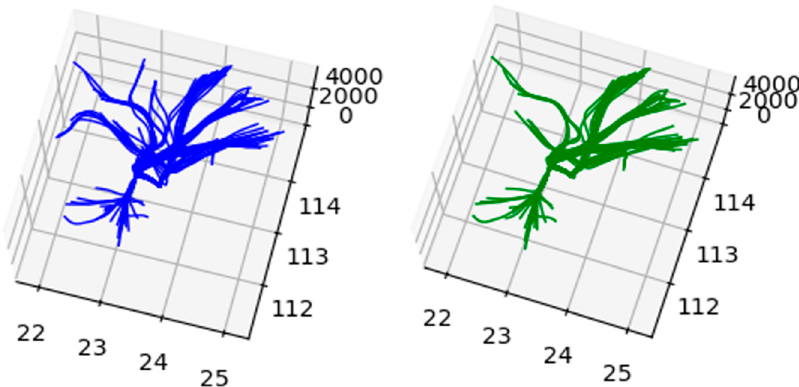
Figure 10. Reconstruction of the sample set comparison.